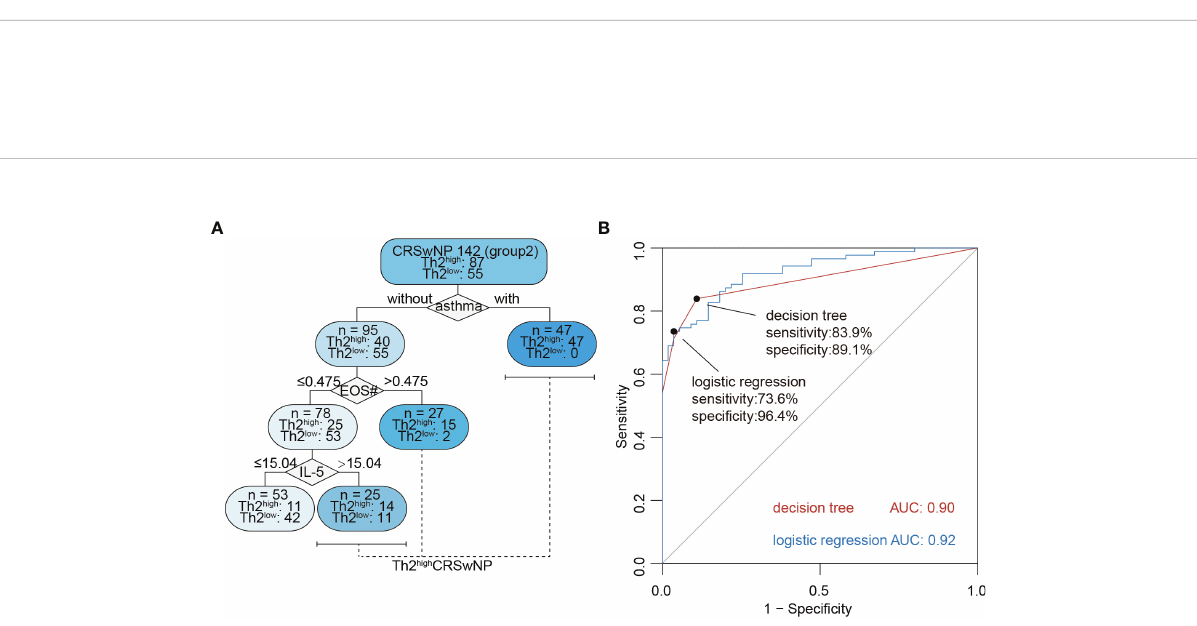
FIGURE 4 Machine learning models for non-invasive diagnosis of Th2 high CRSwNP. (A) The decision tree model for predicting type 2 CRSwNP (Group 2, n = 142); IL-5 = concentration of the cytokine in nasal secretion collected by polyvinyl alcohol (PVA) nasal packs (pg/mL). EOS# = peripheral blood eosinophil absolute count (10 9 /L). (B) Receiver operating characteristic curve (ROC) analysis of logistic regression and decision tree model for prediction of Th2 high CRSwNP (Group 2, n =